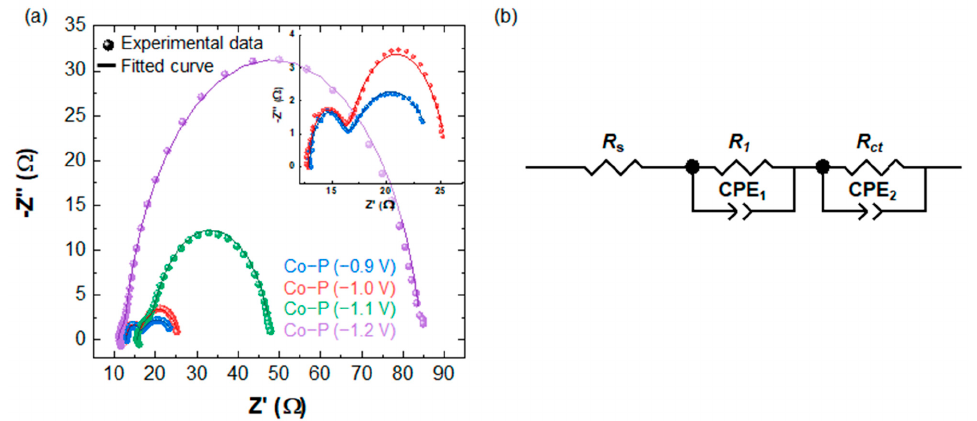
Figure 5. ( a ) Nyquist plots and ( b ) equivalent circuit models of the electrodeposited Co-P electro- catalysts. In ( a ), the impedance spectra were recorded at − 0.2 V vs. RHE. Solid symbols and lines represent the raw data and fitted curves, respectively.